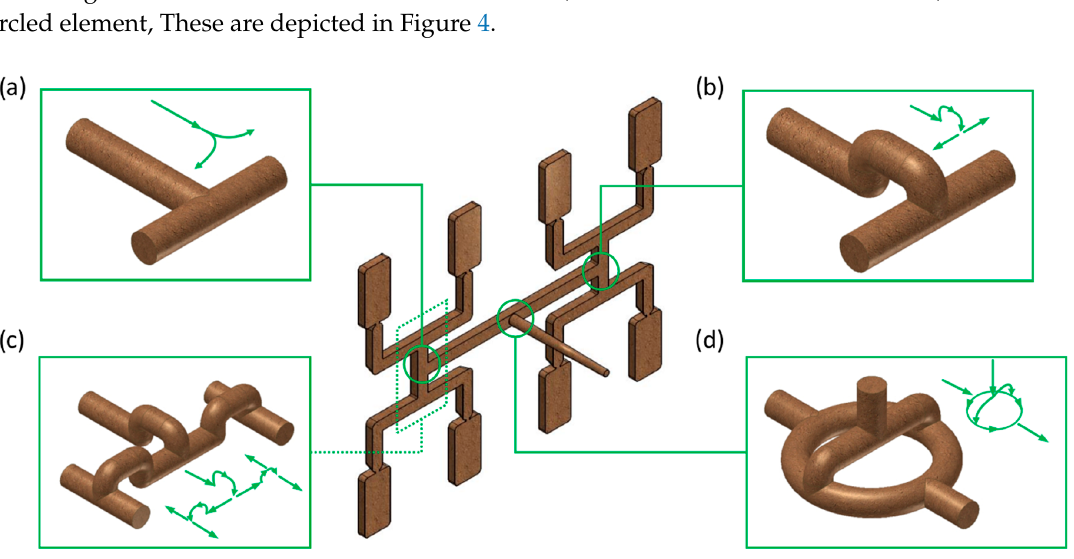
Figure 4. Geometry of runner layouts: ( a ) standard GS , ( b ) one correction element G1 , ( c ) two correction elements G2 , and ( d ) circled element G3. Table 1. Material Characteristics and Process Parameters.